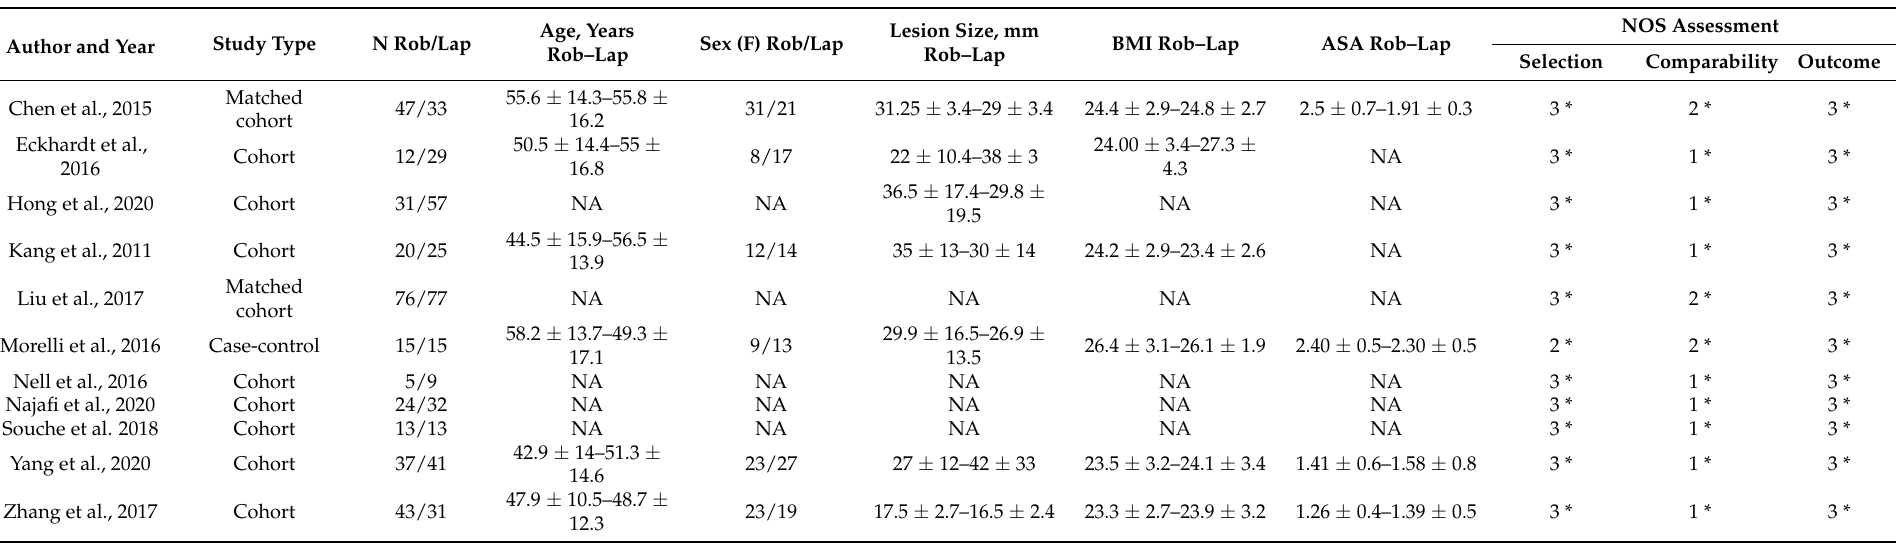
Table 1. Summary of the selected studies with patients’ characteristics and quality assessment according to the Newcastle–Ottawa scale (NOS). NA: not